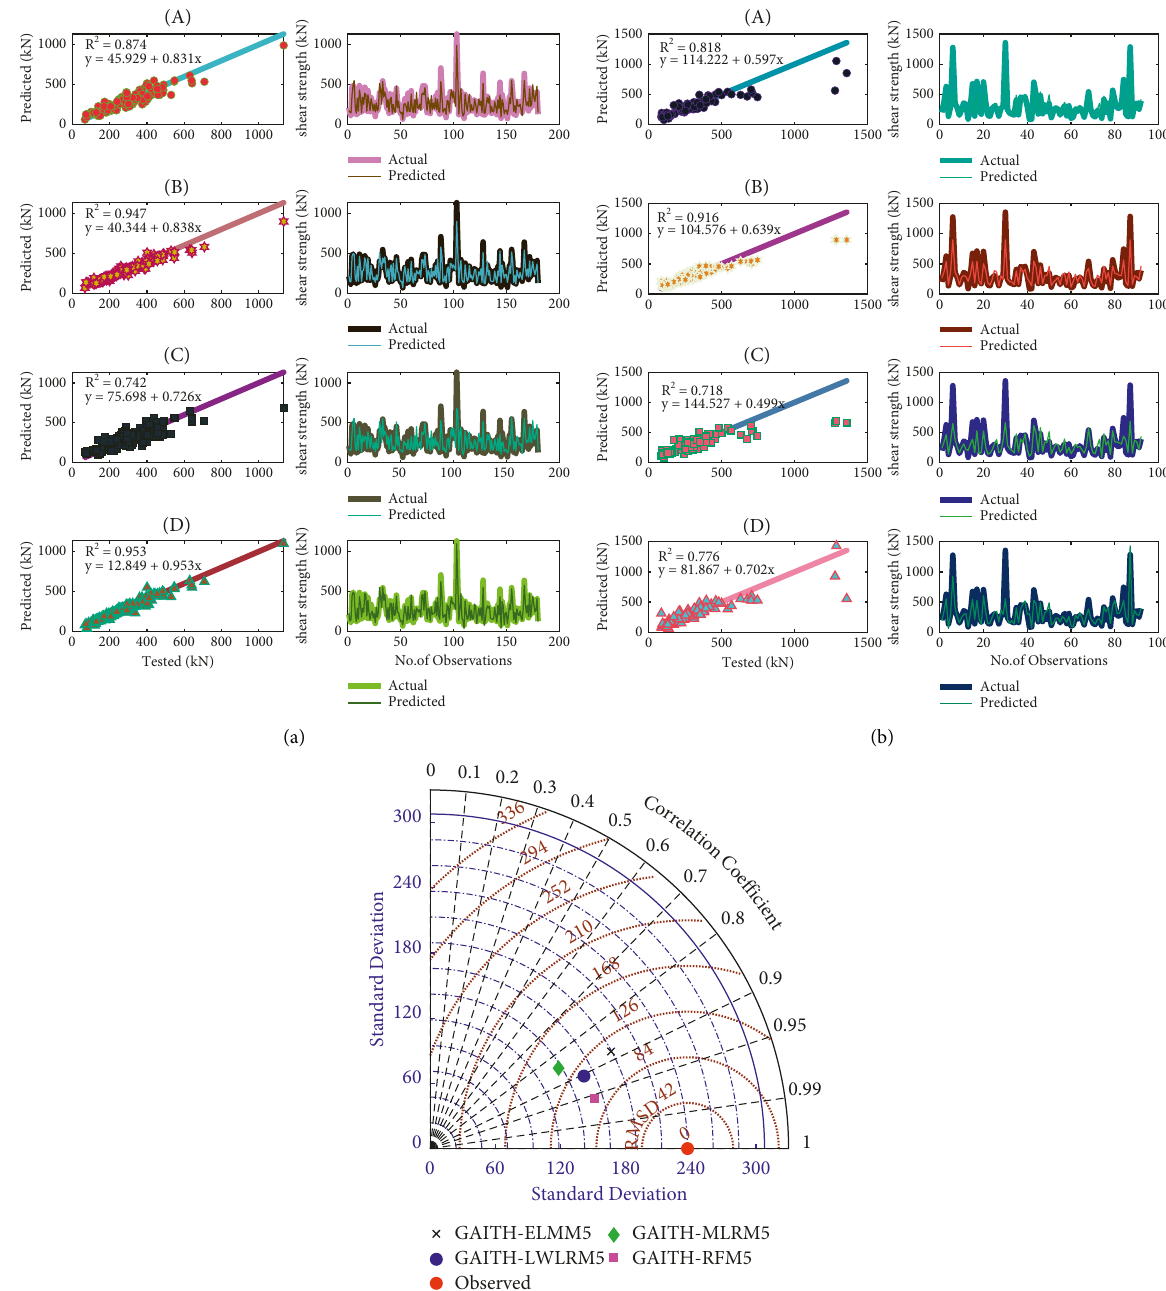
Figure 11: A comparison between the objectives of the models: (A)–(D) represent the GLWLR , and GAITH − ELM GAITH − MLR M M 4 models, respectively. Figures (a) and (b) show scatter plots and line plots for the training and test 4 data, respectively, while figure (c) is a Taylor plot based on the test data. (a) Training data. (b) Testing data. (c) Taylor